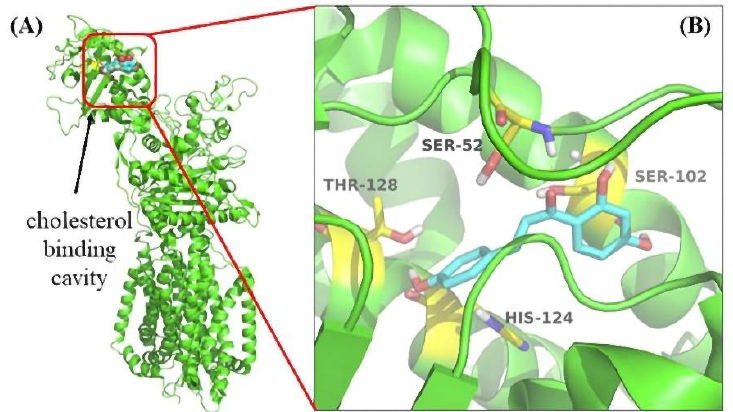
Figure 7. The result of Molecular Docking. ( A ) The cholesterol binding cavity (red) in the NTD. ( B ) Binding modes of ISL to NPC1L1 (PDB: 6V3F). The inhibitor ISL was shown color by element (carbon in cyan). The critical amino acid residues were shown color by element (carbon in yellow).